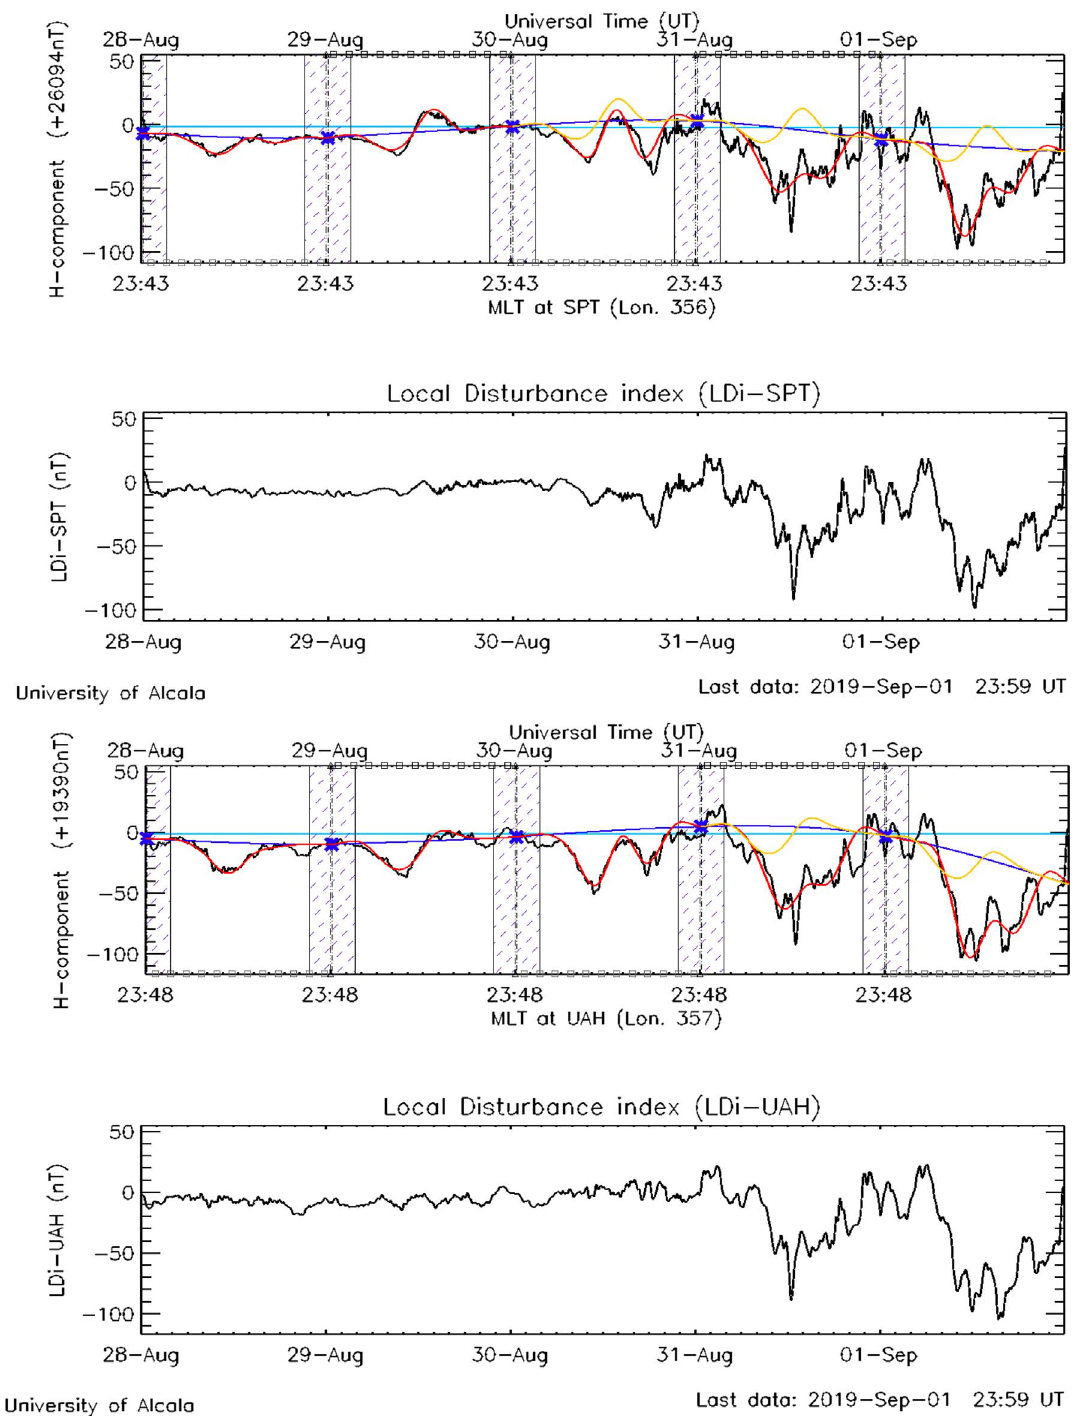
Fig. 7. Two top panels: curves involved in the procedure to obtain the Local Disturbance index (LDi) and the result for SPT data. Two bottom panels are equivalent for UAH-MAG data. Red curves are the solar regular variation fi tting to the data, yellow lines are the adopted solar quiet curves, the blue line is an auxiliary curve for the calculations and the green line is the baseline considering secular